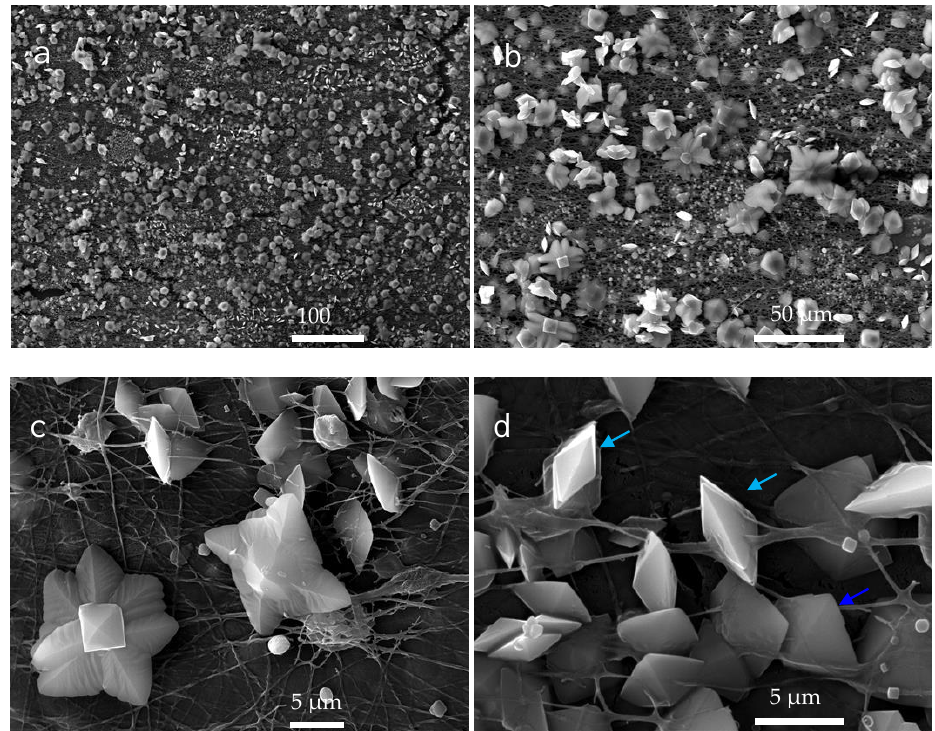
Figure 11. SEM images of CaOx crystals obtained via EC on ITO modified with A-chitosan fibers at different magnifications showing the abundance of smaller crystals ( a ) with flower morphology ( b,c ) and the tetragonal bipyramidal COD ( d ) crystals. Light blue and blue arrows indicate lateral and top views of the tetragonal COD phase, respectively.